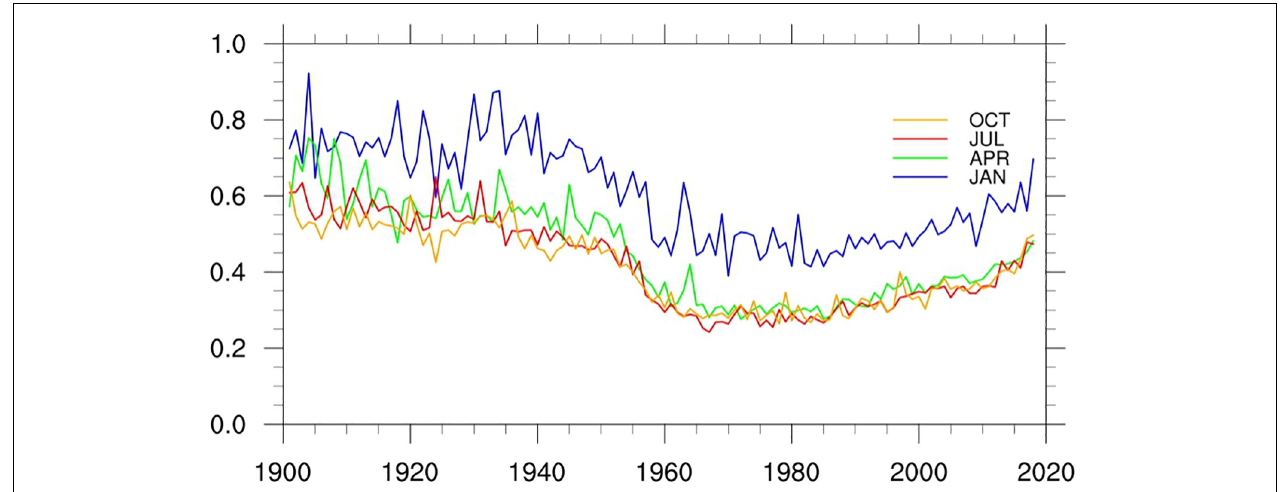
FIGURE 9 | Mean MAEs of the LSAT anomaly from 1900 to 2018 for 4 months (January, April, July, and October).